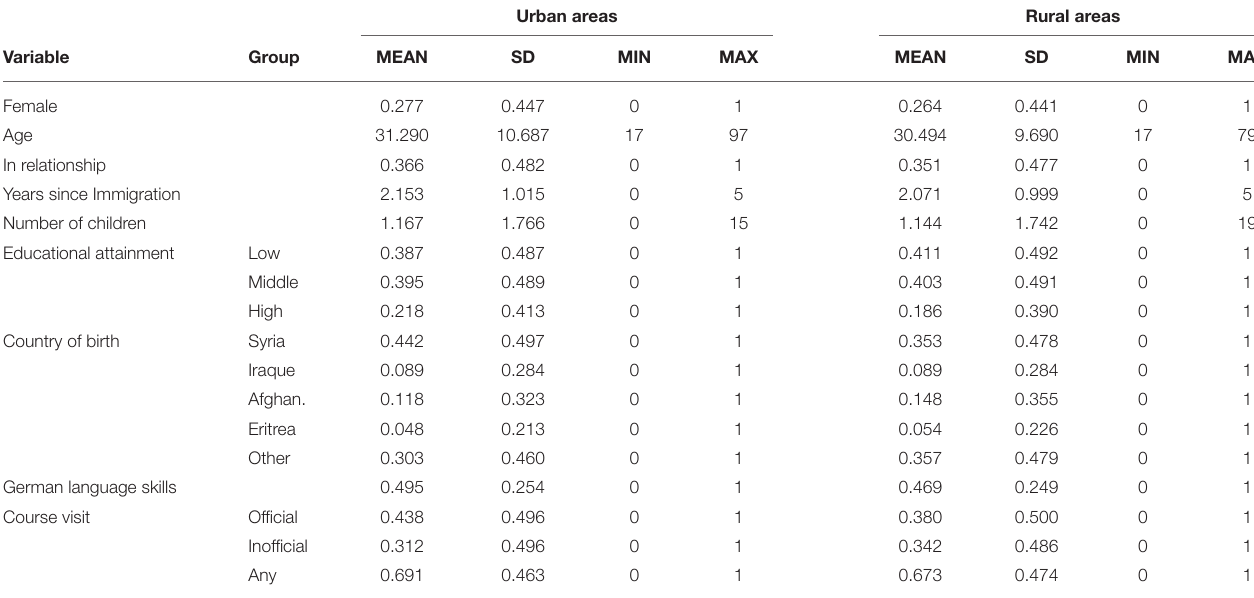
TABLE 1 | Summary statistics.